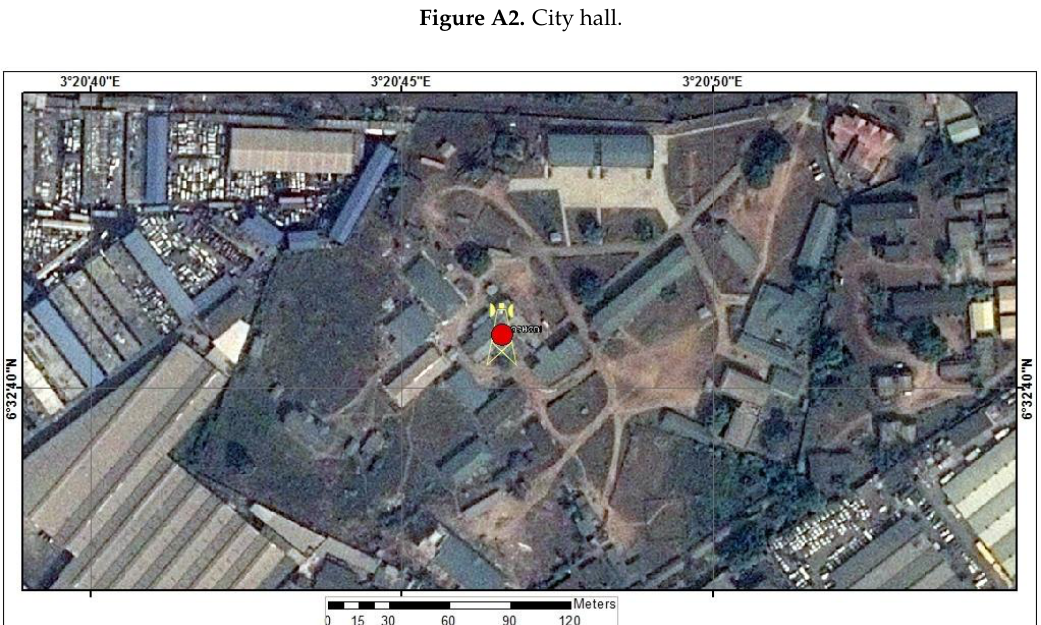
Figure A3. Oshodi.